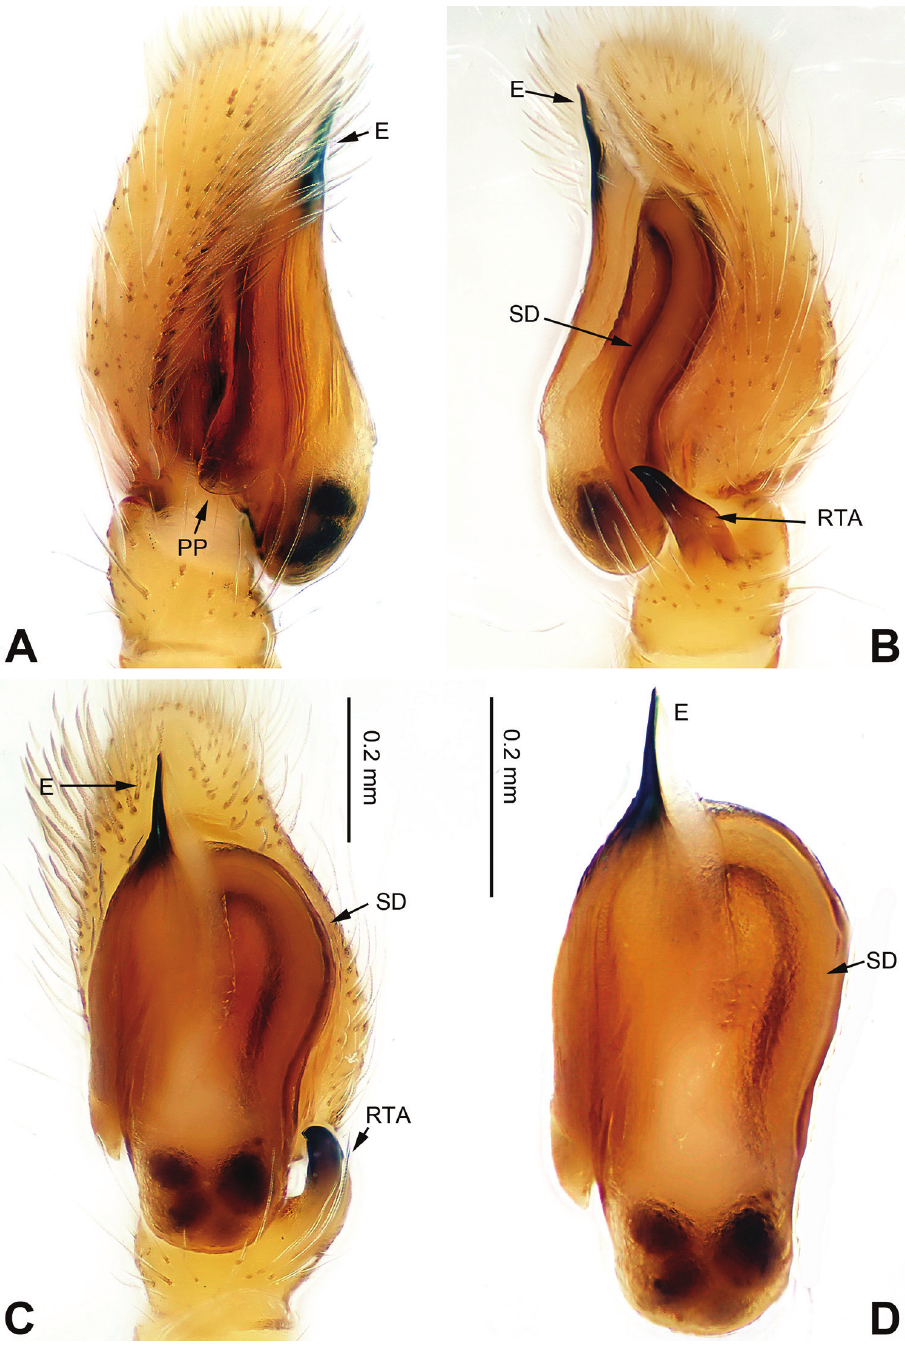
Figure 7. Palp of Bavia exilis sp. n., male holotype. A prolateral B retrolateral C ventral D bulb, ventral. Scale bar equal for A–C